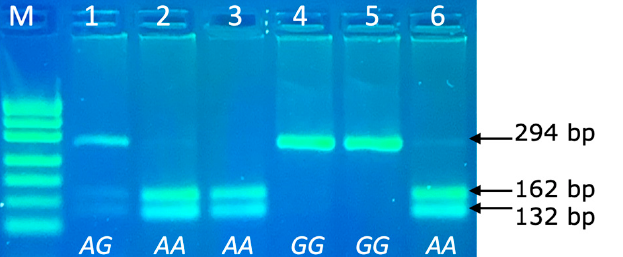
Figure 3. PCR-RFLP of PRL 294bp/ Rsa I genotypes (rs211032652 SNP) in agarose gel electrophoresis. Line M: pUC19/Msp I Ladder (Carl Roth); Line 1: genotype AG (294, 162 and 132 bp); Lines 2, 3, 6: genotype AA (162 and 132 bp); Lines 4-5: genotype GG (294 bp).